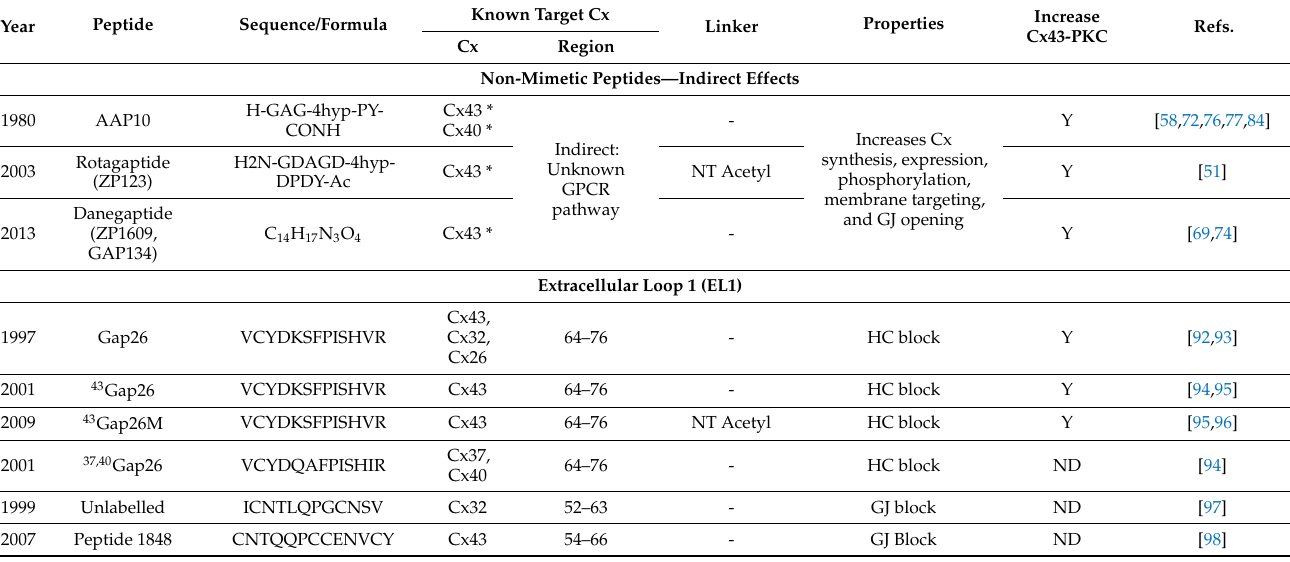
Table 1. Connexin regulating